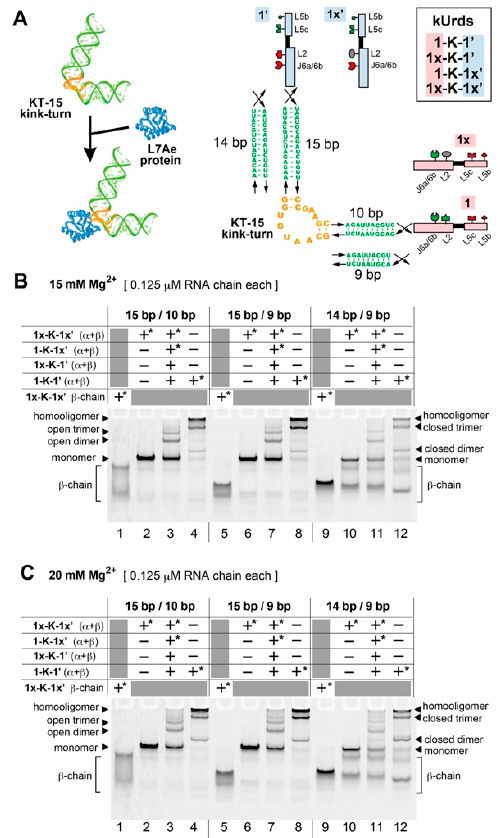
Figure 2. Structures of kUrds and their assembly analyzed by EMSA. ( A ) 3D structures of KT-15 kink-turn motif (orange) with a pair of duplexes (green) and its binding with L7Ae protein (blue). Sequence and secondary structures of the linker elements of kUrds with three distinct pairs of duplexes. Small red and green icons indicate RNA motifs. Mutations in L2 elements to disrupt RzM:RzM interaction are also shown as elliptic gray icons. Sequences and secondary structures of these RNA motifs are shown in Figure S1. ( B ) EMSA of 1-K-1 ′ homopolymers formed in the presence of 15 mM Mg 2+ . Asterisks indicate RNA chains labeled with BODIPY fluorophore. ( C ) EMSA of 1-K-1 (cid:48) homopolymers formed in the presence of 20 mM Mg 2+ . Asterisks indicate RNA chains labeled with BODIPY